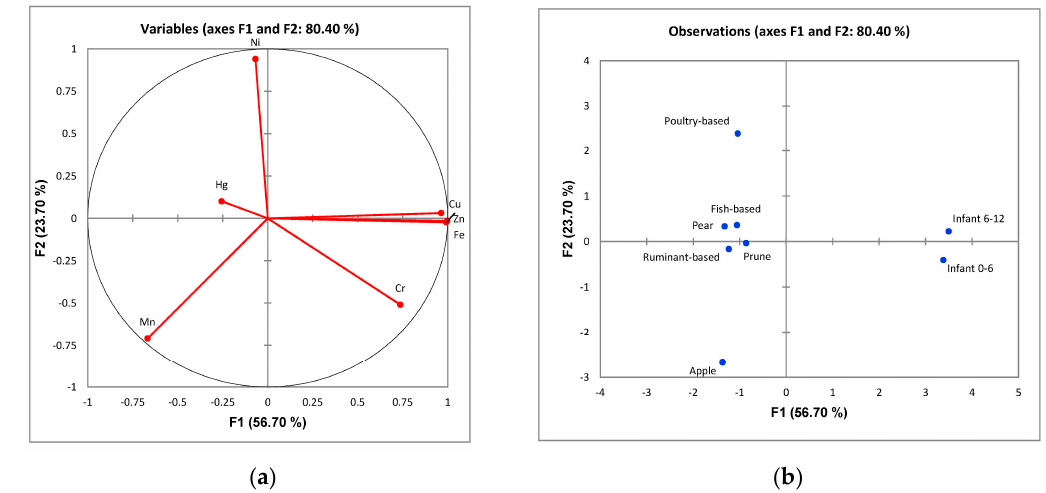
Figure 2. Principal component analysis (PCA) analysis of baby foods and infant formulae characteristics with respect to mineral and toxic metal contents ( a ) the factor loading plot demonstrating the di ff erent groups of variables; ( b ) the factor scores of the two latent